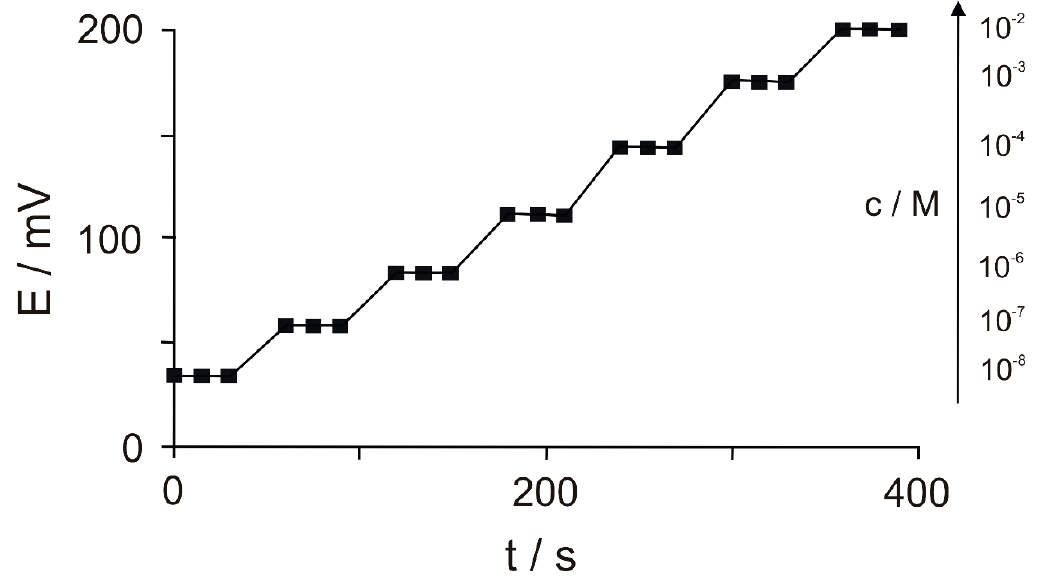
Figure 13. Potentiometric sensor response immersed in Phe solutions of different concentrations [7] .